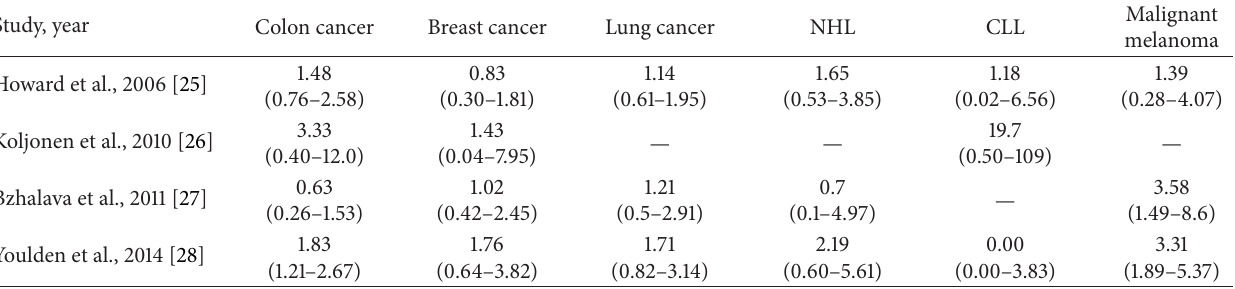
Table 2: Risk estimates individual second malignancies occurring after one year of MCC